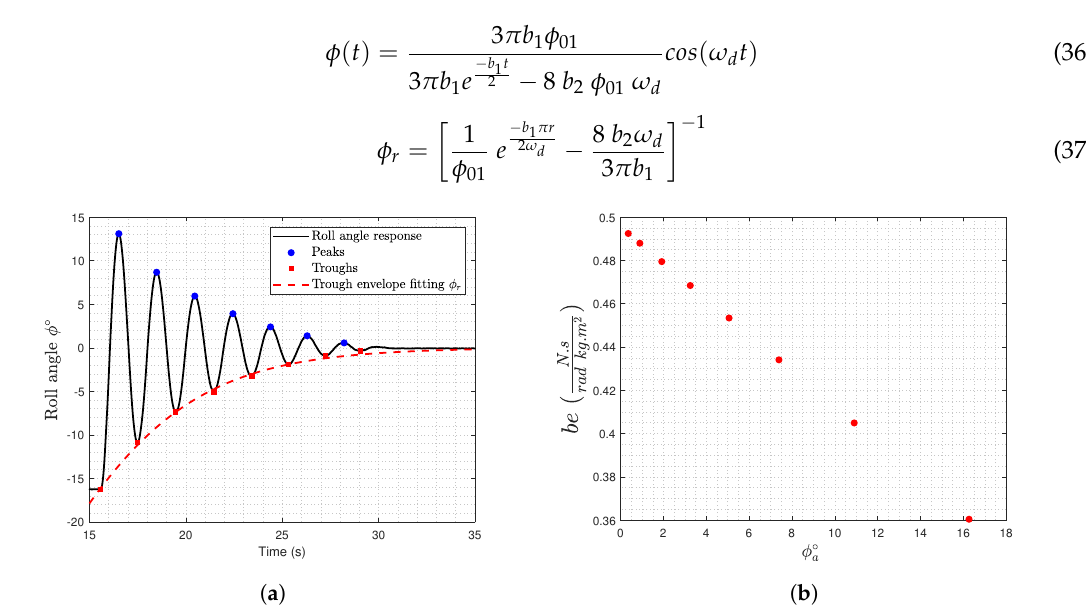
Figure 7. Equivalent linear damping coefficient estimation using the perturbation method, test case 8, see Section 3.3. ( a ) Roll angle decay test envelope nonlinear curve fitting with Equation (37); ( b ) Equivalent linear damping coefficient using the estimated coefficients b 1 and b 2 Equation